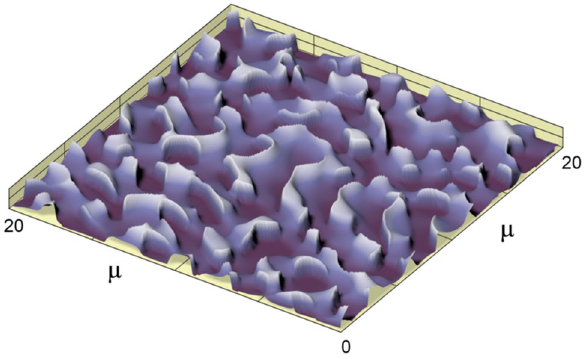
Figure 10. Fragment of the microrelief of the multilevel kinoform in one of the elementary G ij